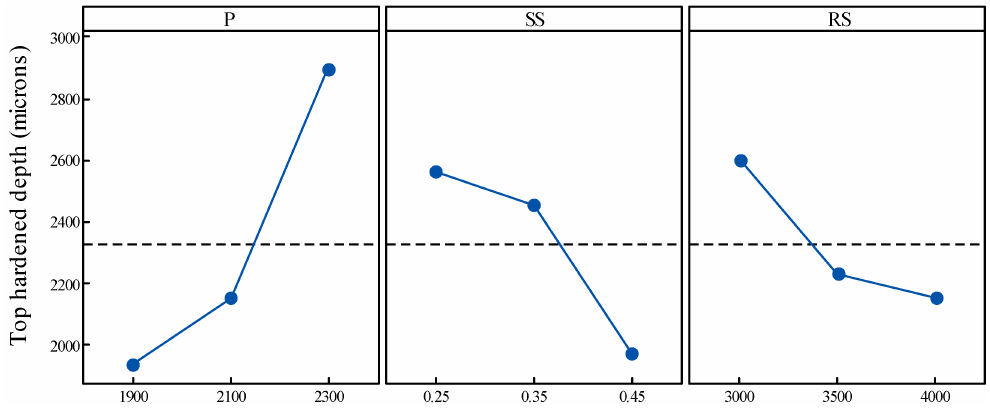
Figure 10. Main e ff ects of the process parameters on the tooth top hardened depth.